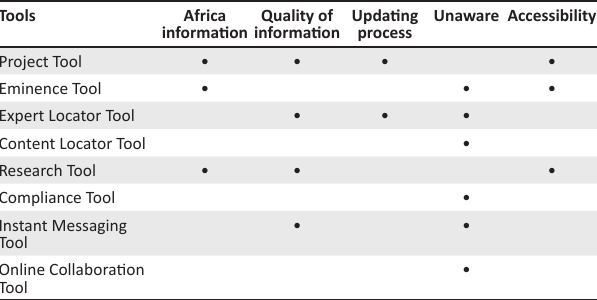
TABLE 3: Gaps for